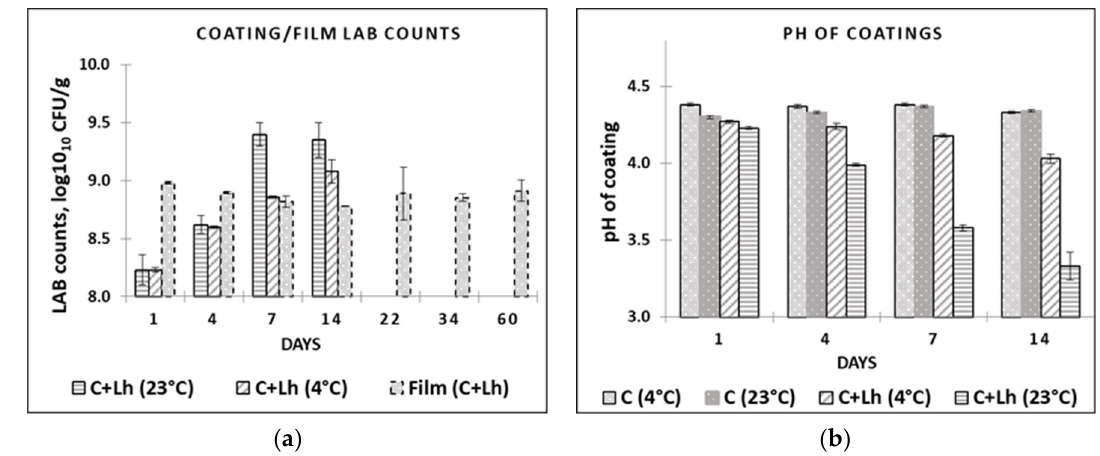
Figure 1. LAB counts ( a ) in coating solutions and films and pH; ( b ) in coating solutions at different temperatures (at 4 °C and 23 °C) during their storage. C—plain coating; C + Lh—coating solution with L. helveticus .